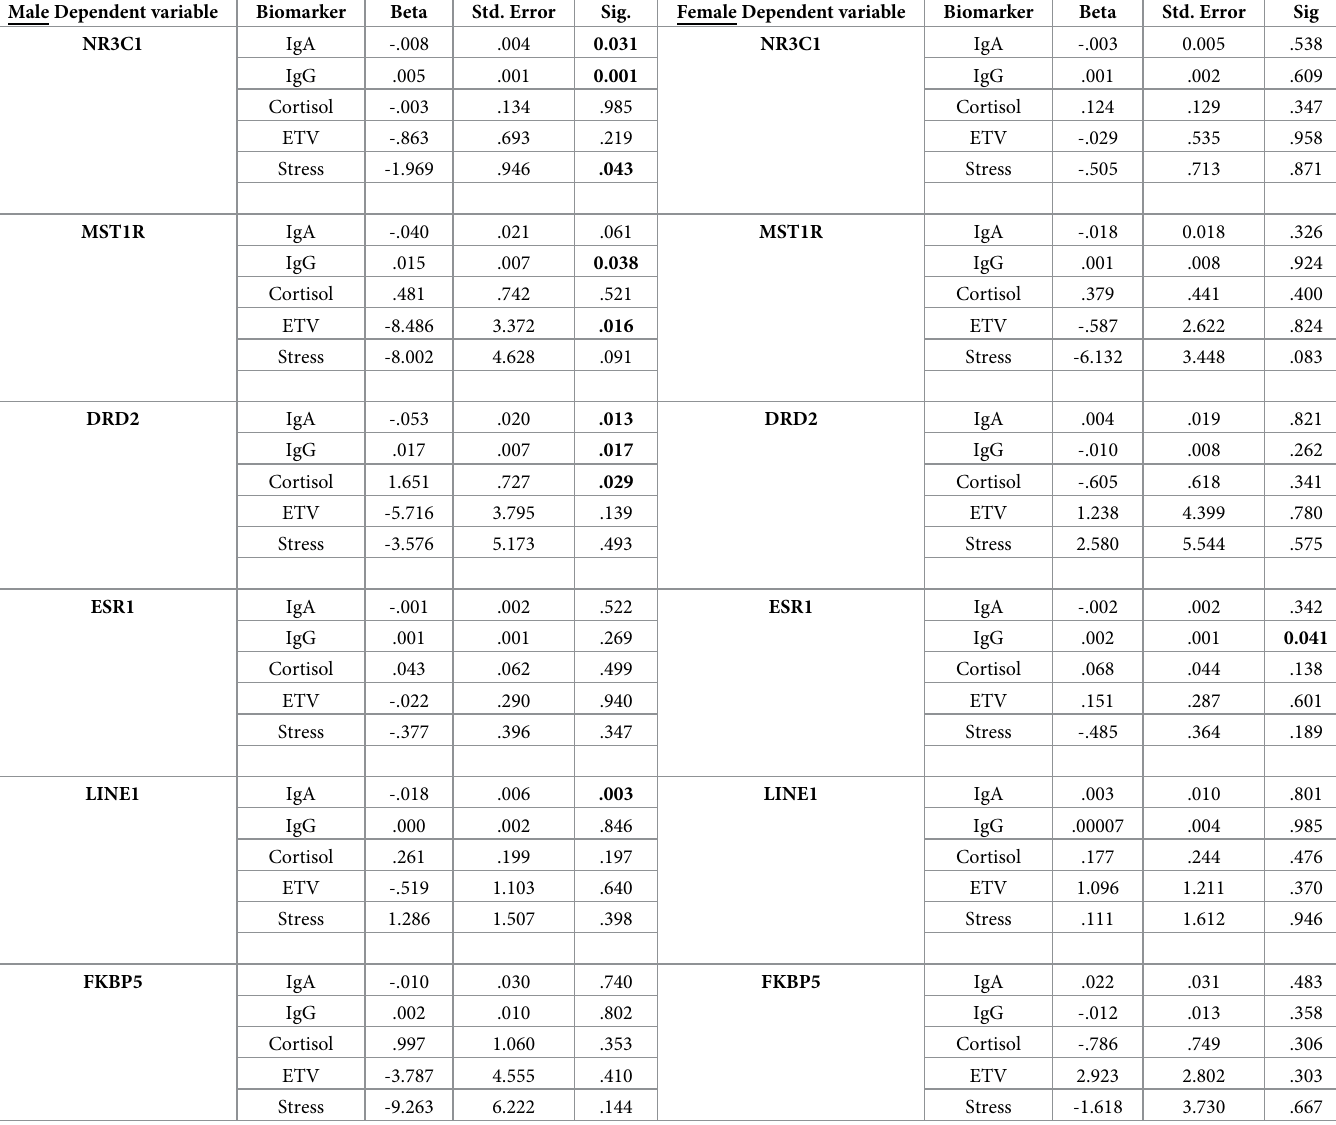
Table 1. The DNA methylation analysis of genes and correlation with biomarkers in both males and females are shown. Male Dependent variable